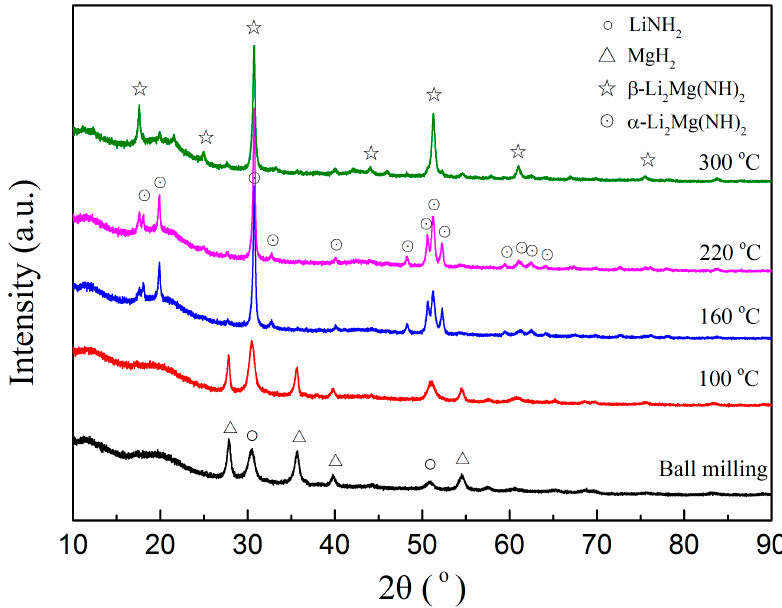
Figure 4. XRD patterns for 2LiNH 2 ‐ MgH 2 ‐ 0.1Li 3 AlH 6 sample at different stages.